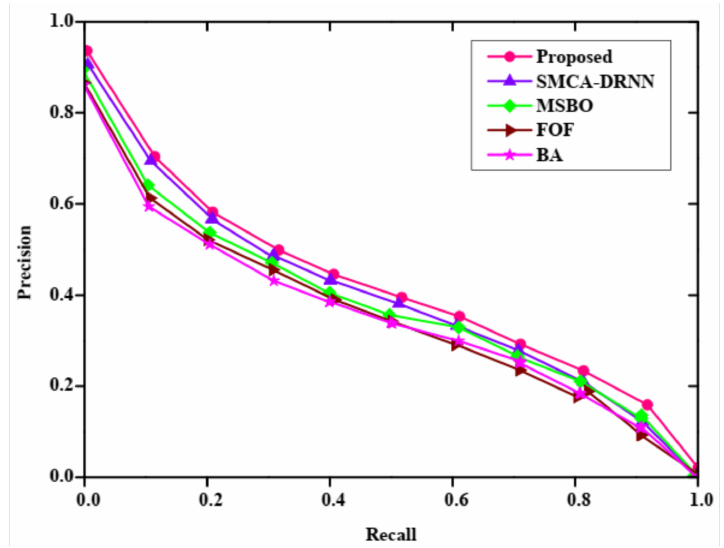
Figure 6. Comparative analysis of precision and recall with query